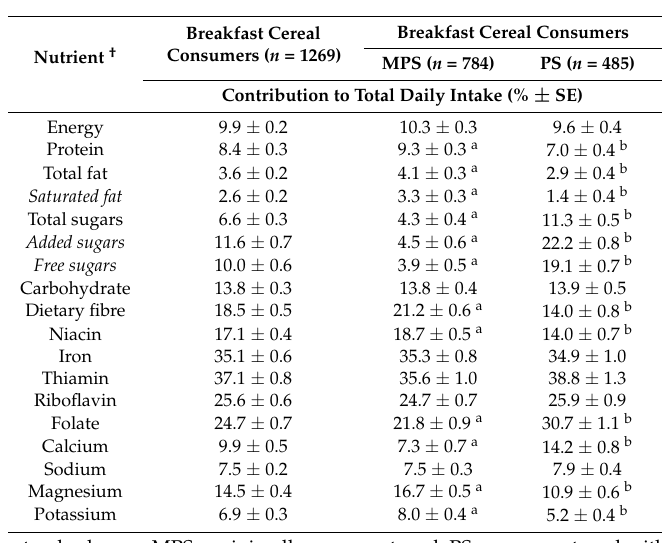
Table 4. The mean contribution of breakfast cereal to total daily energy nutrient intakes by pre-sweetening * of the breakfast cereal in breakfast cereal consumers aged 2–18 years based on the 2011–2012 National Nutrition and Physical Activity Survey ( n =